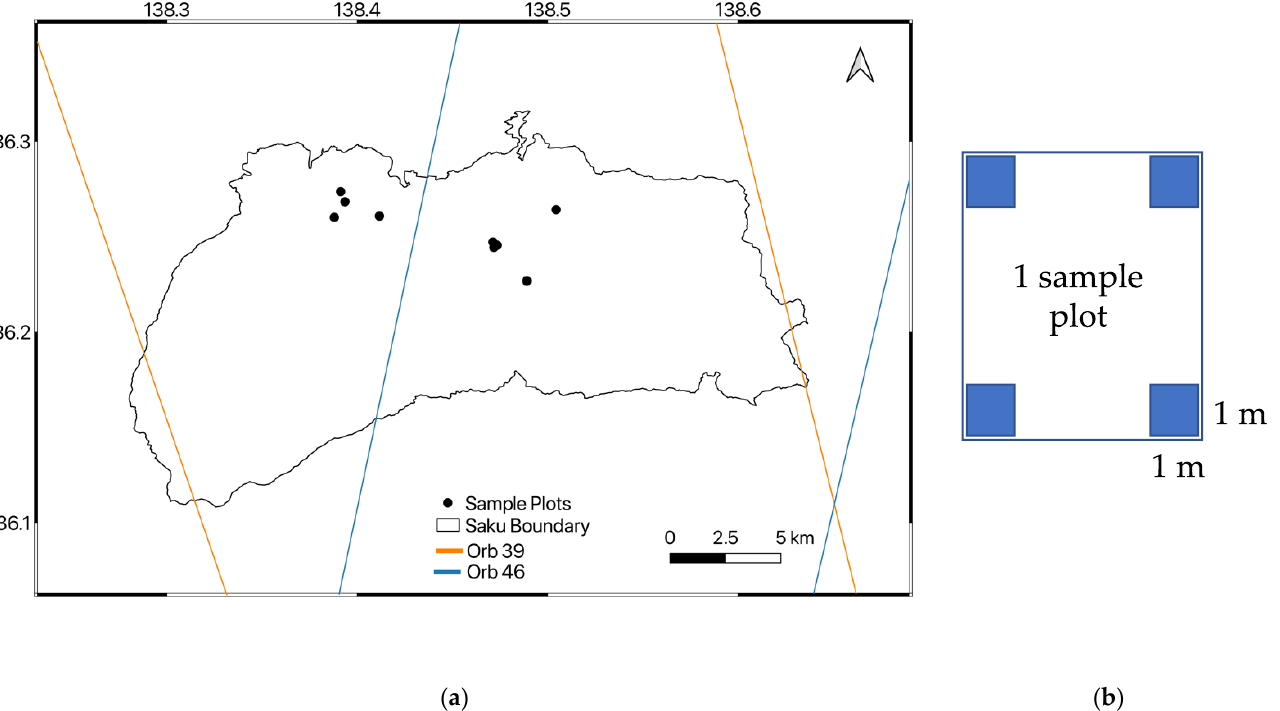
Figure 3. ( a ) Black circles indicate the locations of the 10 sample plots in Saku. The black line depicts the city boundary. Orange and blue solid lines indicate a swath width of orbit 39 and 46, respectively. ( b ) Four observation points with square sizes of 1 m 2 set in each paddy field of the sample plot.